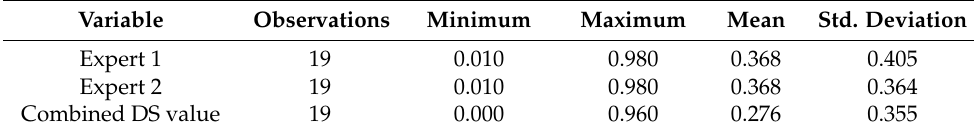
Table 12. Summary of